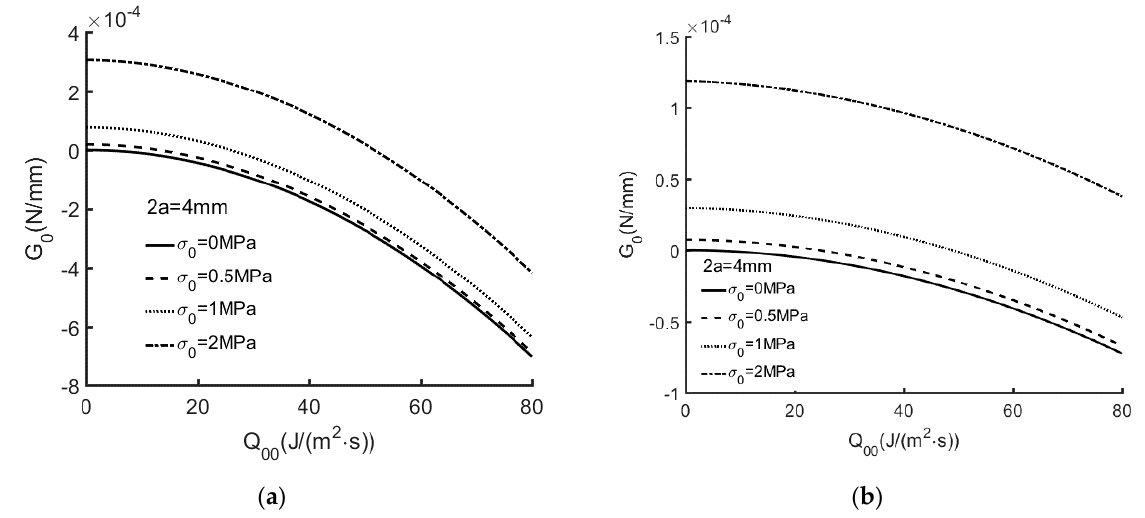
ε = 0. (2a = 4 mm). The orthotropic material ε = 0. (2a = 4 mm). The isotropic material